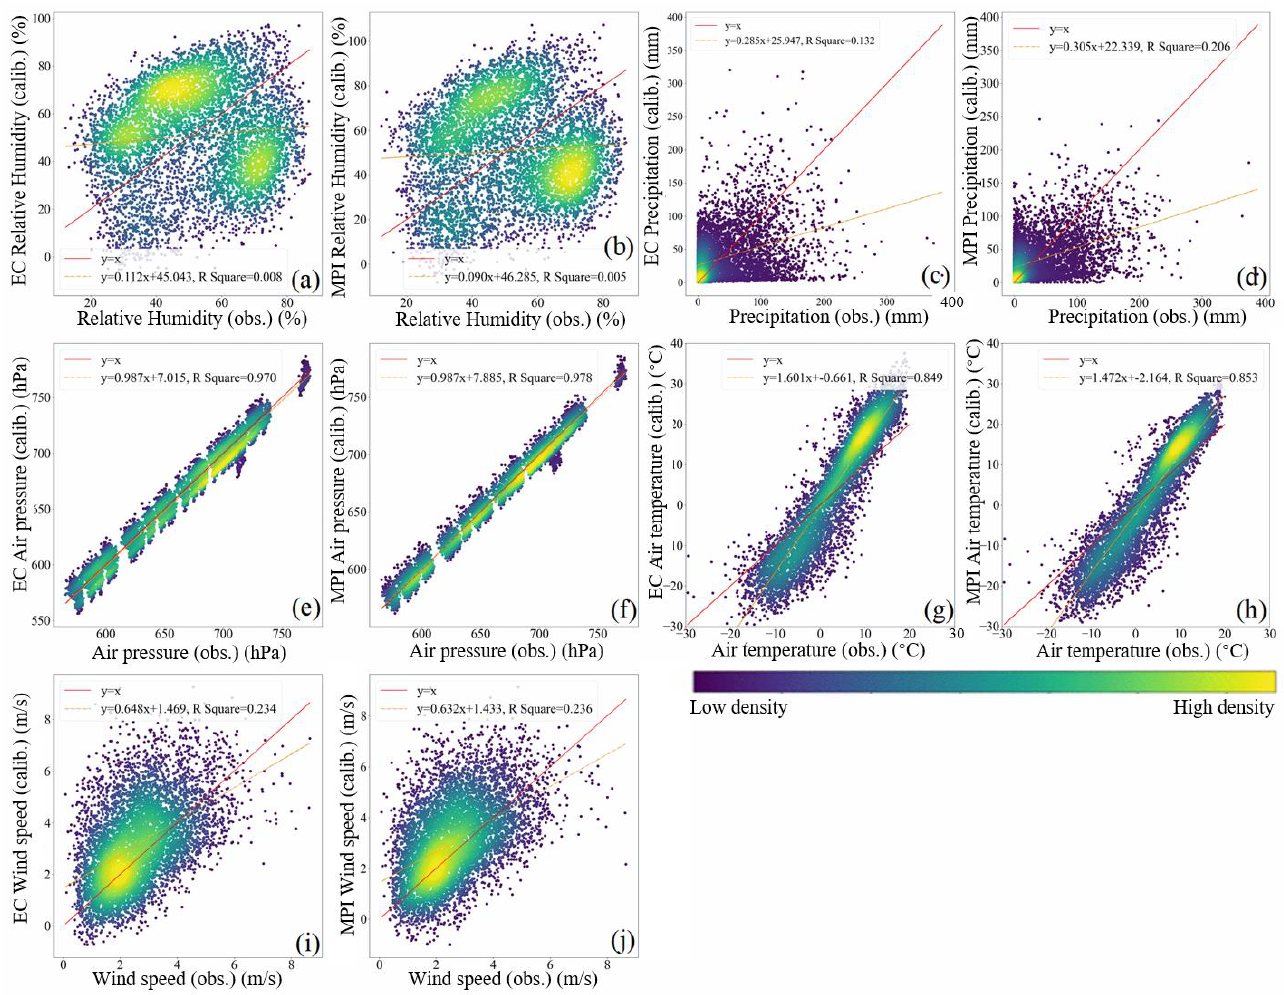
Figure 12. Calibrated results (the ordinates) by the delta downscaling method (Delta) and the corresponding monthly observations (the abscissae) of five major meteorological variables at the 36 QTP sites for the first adjustment (results corresponding to 1985 – 1999). The symbolic notations are the same as in Figure 3. Subplots ( a , c , e , g , i ) show the results from EC GCM simulations; and ( b , d , f , h , j ) the MPI GCM simulations. Table 7. Comparison of performance of the three comparative adjustment methods in terms of mean RMSE and MAE over the 36 QTP sites after the first adjustment (1985 – 1999) based on two GCM simulations (EC and MPI). N = 180 for each site. This Variable